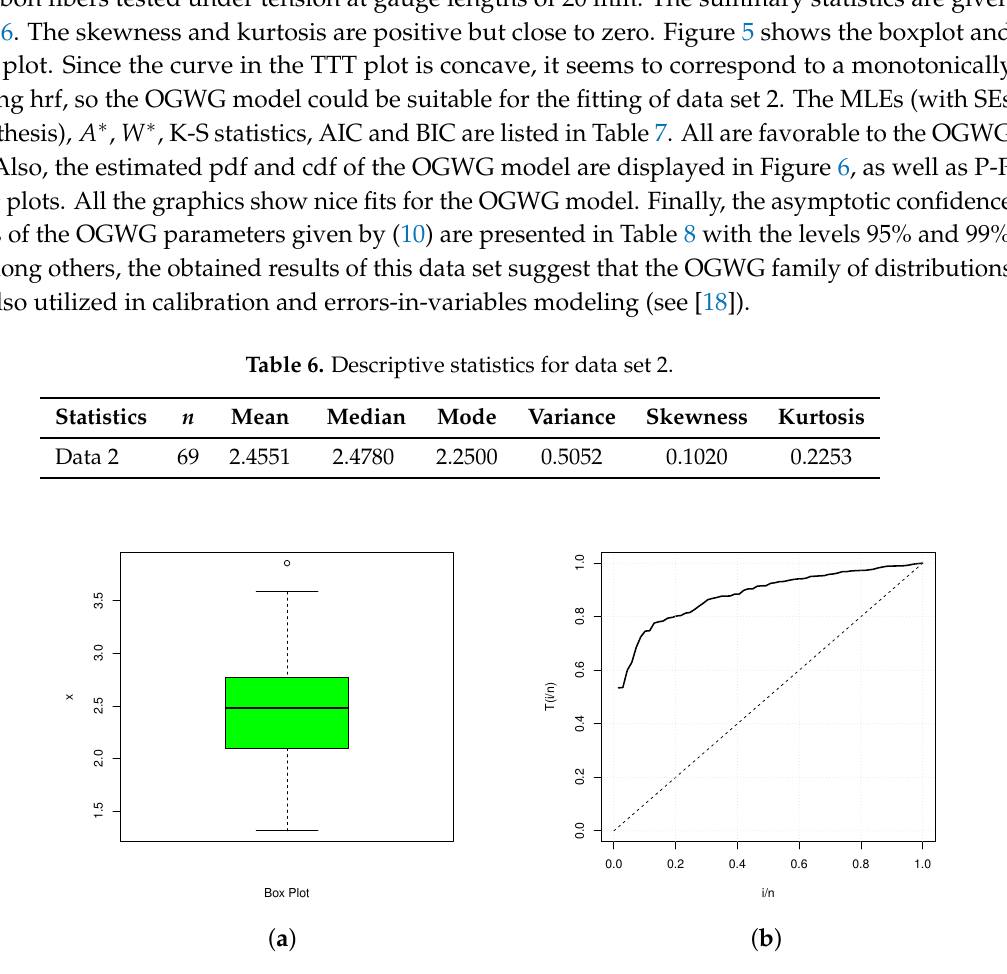
Figure 5. ( a ) Boxplot and ( b ) TTT plot for data set